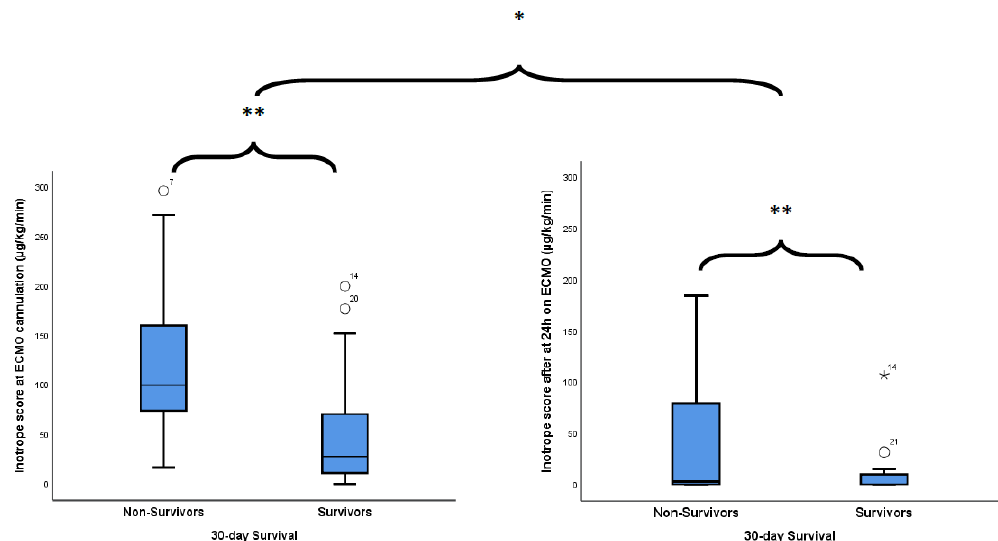
Figure 1. Inotrope score change between pre and post-VA-ECMO cannulation according to patients’ 30-day status. * p < 0.001 between pre-ECMO and after 24 h on ECMO, ** p = 0.004 between survivors and non-survivors. Table 3 describes the ICU events and outcomes among ECMO-treated patients with All MAPE according to 30-day survival status. When comparing non-survivors to survivors, significantly higher SAPS II scores, pre-ECMO IS and IS after 24 h of ECMO were found in non-survivors. ECMO duration and both ICU and hospital lengths of stay were shorter among non-survivors. For in-ICU ECMO-related complications, haemorrhage levels and PRBC units transfused were also significantly higher in non-survivors. Table 3. ICU events and outcomes among ECMO-treated patients for massive PE according to 30-day survival status. Variables